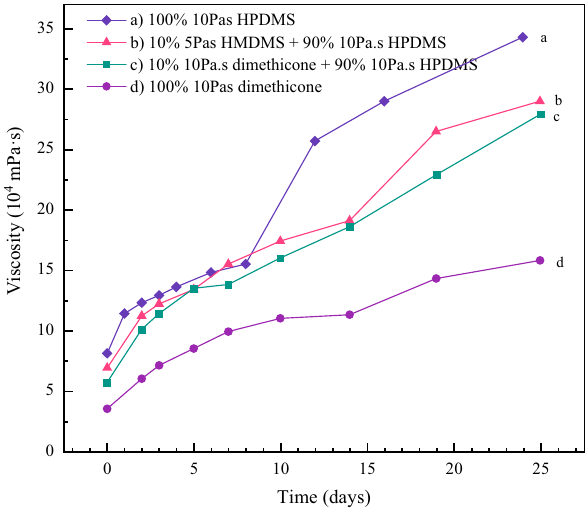
Figure 9: Changes in viscosity during the storage of RTVs using di ff erent polymer